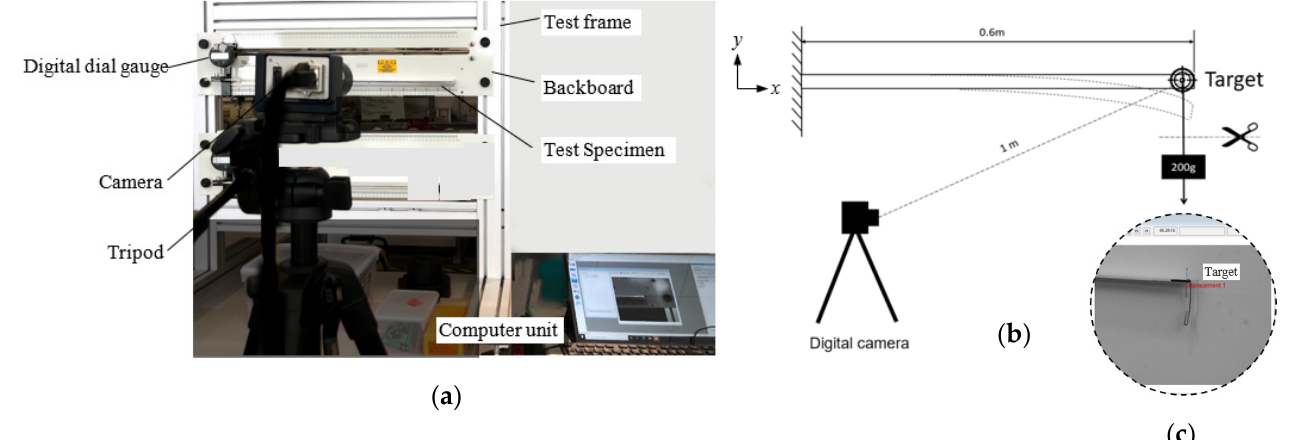
Figure 2. ( a ) Equipment setup presenting the Cantilever Beam Test Frame as measured by the DIC system, ( b ) A diagram of the equipment’s setup displaying the camera’s position, ( c ) the field of view, and a target that Video Gauge software has recorded. Table 1. Density of